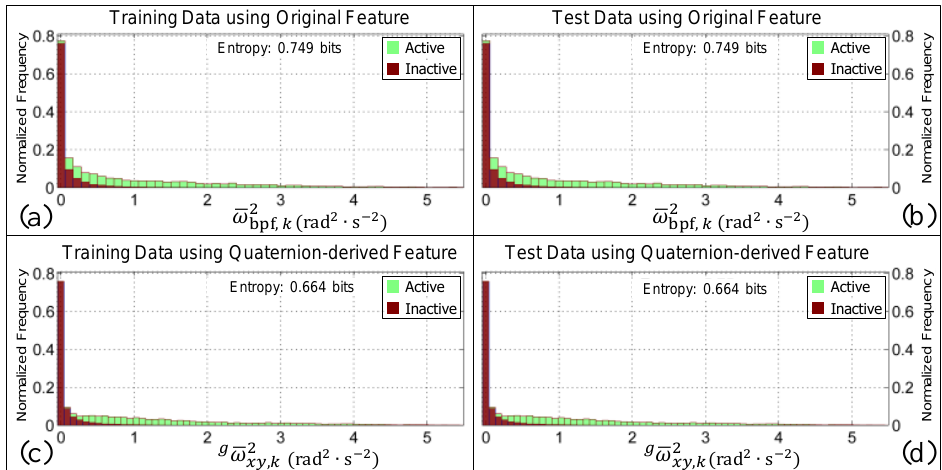
Figure 6. The normalized histograms of the active (i.e., the walking, walking upstairs, walking downstairs, and postural transition classes pooled together) and inactive (i.e., the standing and sedentary classes pooled together) classes for the features ¯ ω 2 and g ¯ ω 2 . Panels ( a , c ) are generated xy , k bpf, k from the training data (i.e., the pooled data from the younger and older cohorts, respectively). Panels ( b , d ) are generated from the test data (i.e., the pooled data from the younger and older cohort after they have been virtually re-oriented using the quaternions in Figure 1b–f). The bar charts in all panels are ‘stacked’. Note that the Shannon entropy for the quaternion-derived feature is both smaller and consistent, irrespective of the data it is calculated from, which suggests that it will be better at distinguishing the activity classes and is orientation